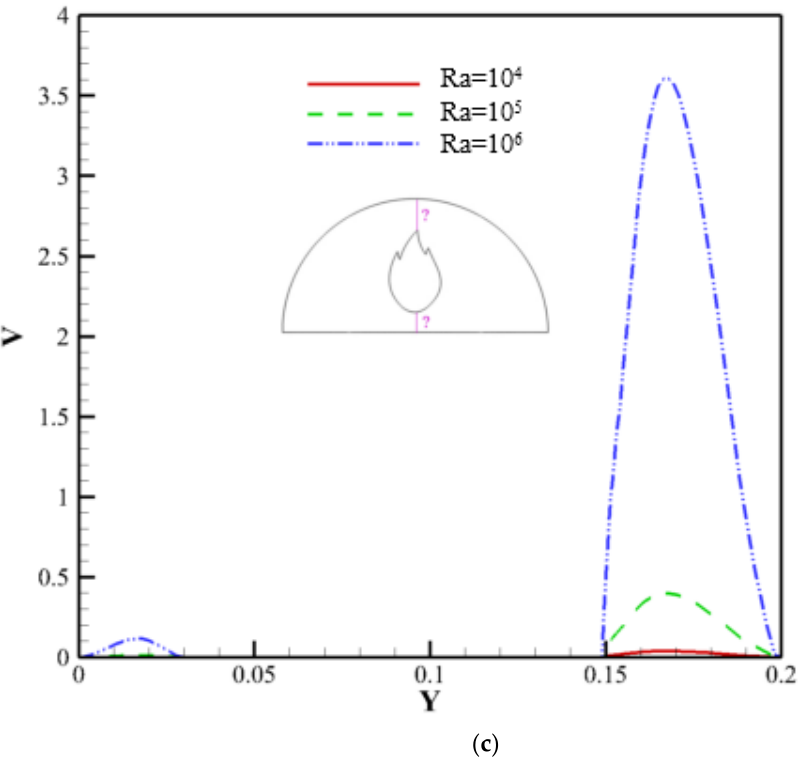
Figure 6. Variation of ( a ) Nusselt number at the enclosure heated wall, ( b ) temperature along verti ‐ cally mean position and, ( c ) velocity alongside mean vertical location for different values of Ra at ( φ = 0.02, Ha = 50, Rd = 0.5, Da = 10 − 4 and L = 0.2).